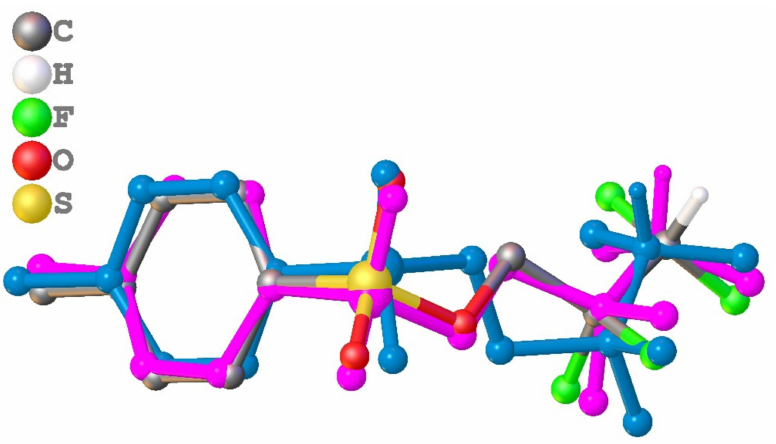
Figure 3. Overlaid molecules in structures 2a and 2b . Color code: 2b , molecule A —magenta; 2a , molecule B —blue; and 2a is colored by element.